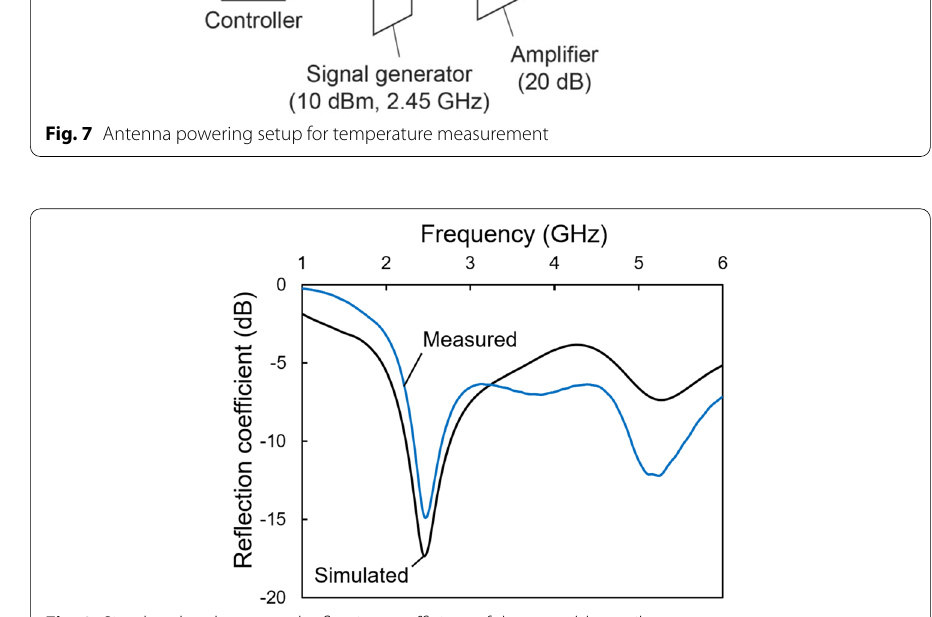
Fig. 8 Simulated and measured reflection coefficient of the wearable textile